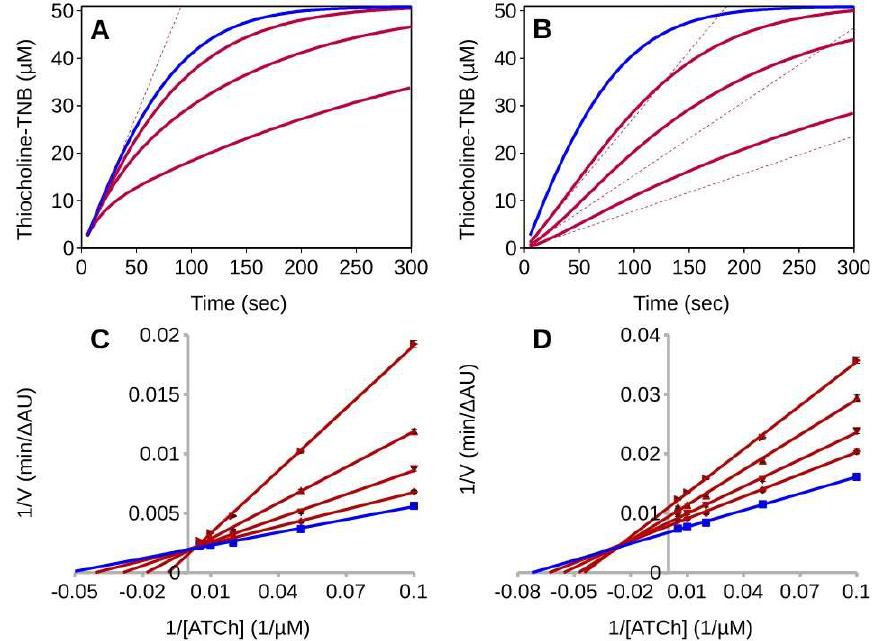
Figure 4. Steady−state analysis of TcAChE inhibition by GAL. ( A , B ) Time course of product formation for Tc AChE (200 pM) and ATCh (50 µM) in the absence (blue line) or presence (red lines) of GAL (30, 60, 180 nM). Dashed lines represent the slope of the first 10 s of reaction. ( A ) Reactions started with the enzyme (i.e., with no E-I pre-incubation). The initial rates are substantially unaffected by the presence of GAL and are a large overestimation the steady-state inhibited rates, which are only attained after 30–60 s from the start of the reactions. ( B ) Reactions started with substrate after a 20 min of E-I pre-incubation. Curves show an upward curvature so that initial velocities underestimate the steady-state turn-over rates. ( C , D ) Overlaid Lineweaver-Burk reciprocal plots of the TcAChE initial velocity (V) at increasing substrate concentrations ([ATCh] = 0–200 µM) in the absence and in the presence of inhibitors. Data points are average values of three replicates. Lines were derived from a weighted least-squares analysis of the data points. ( C ) Reaction started with enzyme (200 pM), in the absence or presence of GAL (0, 50, 100, 200, 400 nM). ( D ) Reaction started with substrate after an E-I pre-incubation time of 20 min in the absence (blue lines) or presence (red lines) of GAL (5, 10, 20, 30 nM). Enzyme concentration was 50 pM.